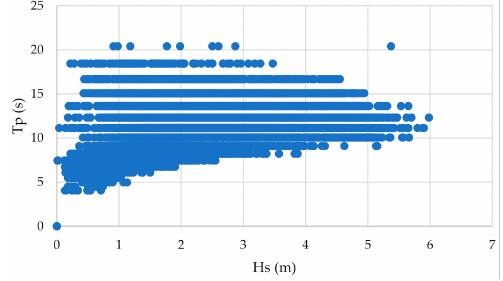
Figure 6. Relation between H s and T p .